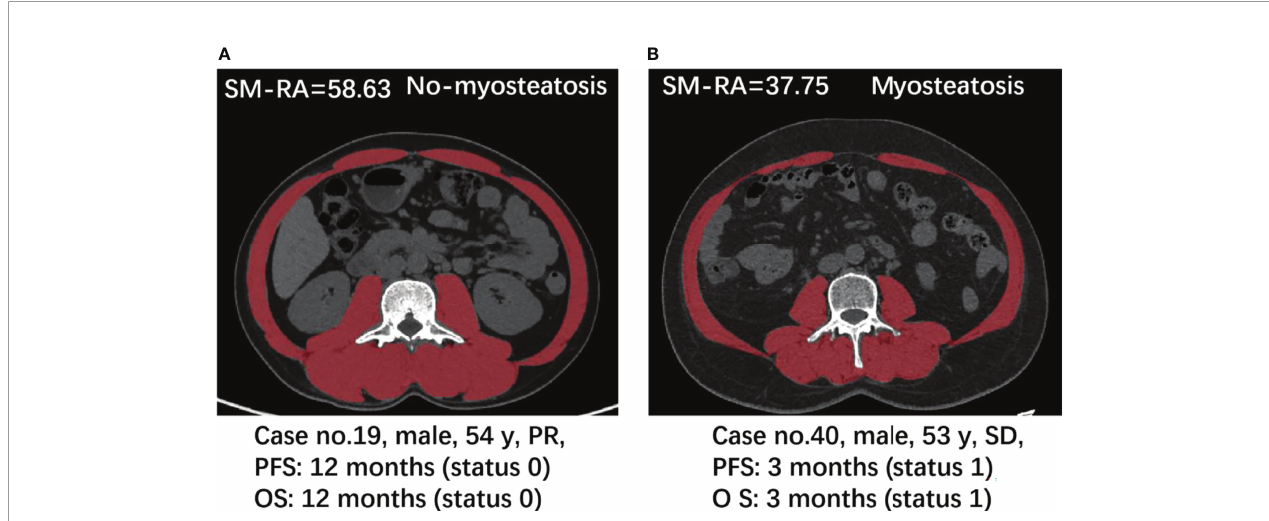
FIGURE 3 | Case presentation. Axial CT images at the L3 level used for the measurement of multiple parameters for body composition, respectively in a 54-year-old man with PR (A) and a 53-year-old man with SD (B)